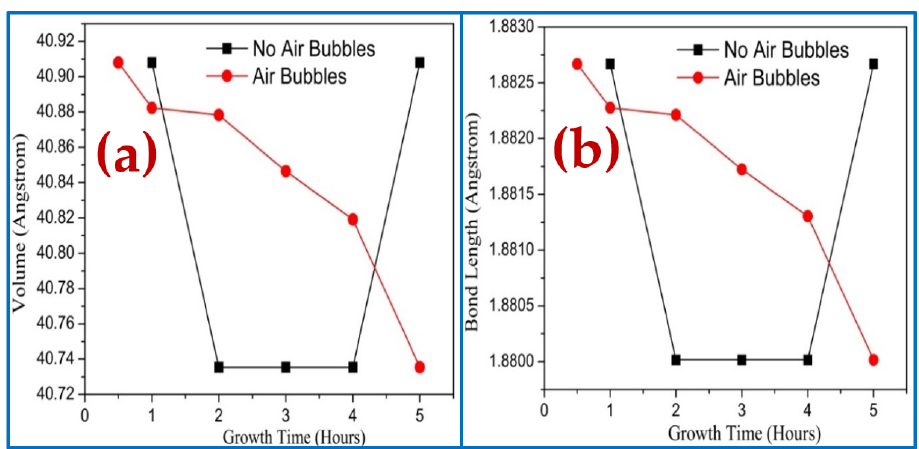
Figure 13. Effect of growth times on ZnO NRs of diffraction peak (002) fabricated where air bub- bles were not involved and where air bubbles were involved: ( a ) volume of hexagonal cell and ( b ) bond length.